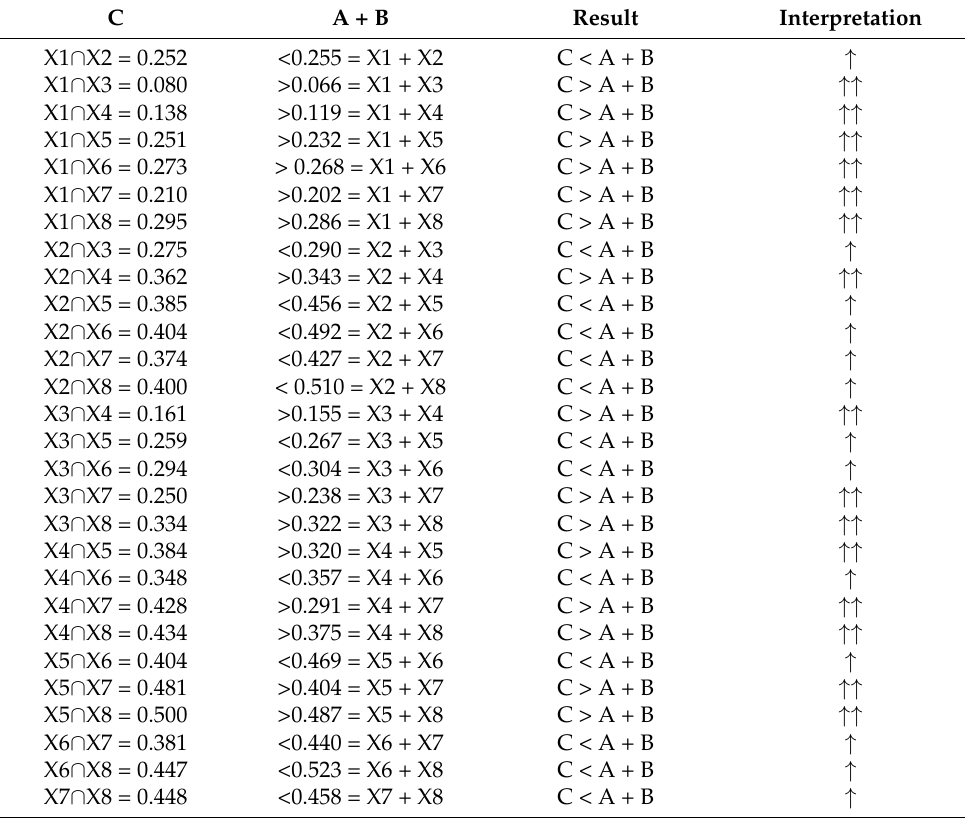
Table 6. Interaction detection factors results.